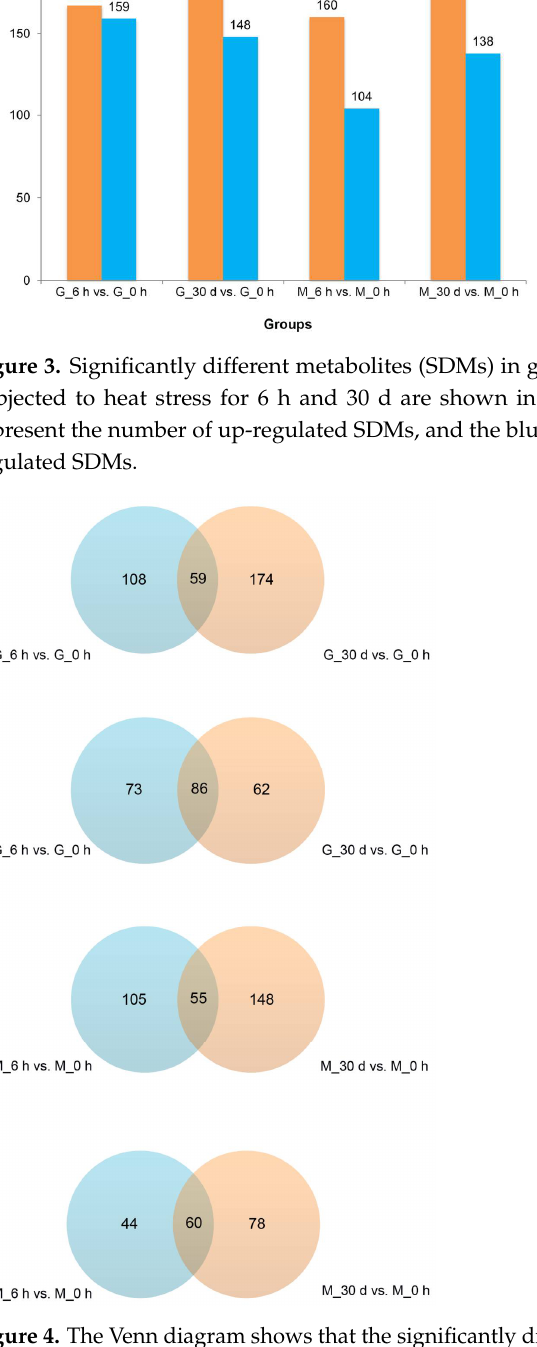
Figure 4. The Venn diagram shows that the significantly different metabolites (SDMs) overlap in each comparison. A: up-regulated SDMs overlap in G_6 h vs. G_0 h and G_30 d vs. G_0 h. B: down- comparison. ( A ): up-regulated SDMs overlap in G_6 h vs. G_0 h and G_30 d vs. G_0 h. ( B ): down- regulated SDMs overlap in G_6 h vs. G_0 h and G_30 d vs. G_0 h. C: up-regulated SDMs overlap in regulated SDMs overlap in G_6 h vs. G_0 h and G_30 d vs. G_0 h. ( C ): up-regulated SDMs overlap in M_6 h vs. M_0 h and M_30 d vs. M_0 h. D: down-regulated SDMs overlap in M_6 h vs. M_0 h and M_30 d vs. M_0 h. M_6 h vs. M_0 h and M_30 d vs. M_0 h. ( D ): down-regulated SDMs overlap in M_6 h vs. M_0 h and M_30 d vs. M_0